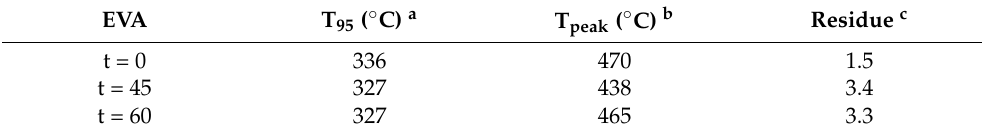
Table 3. Onset temperatures of degradation, temperatures at maximum rate of decomposition and residual masses of EVA + LDH-MA 5% at 0, 45 and 60 days of exposure.